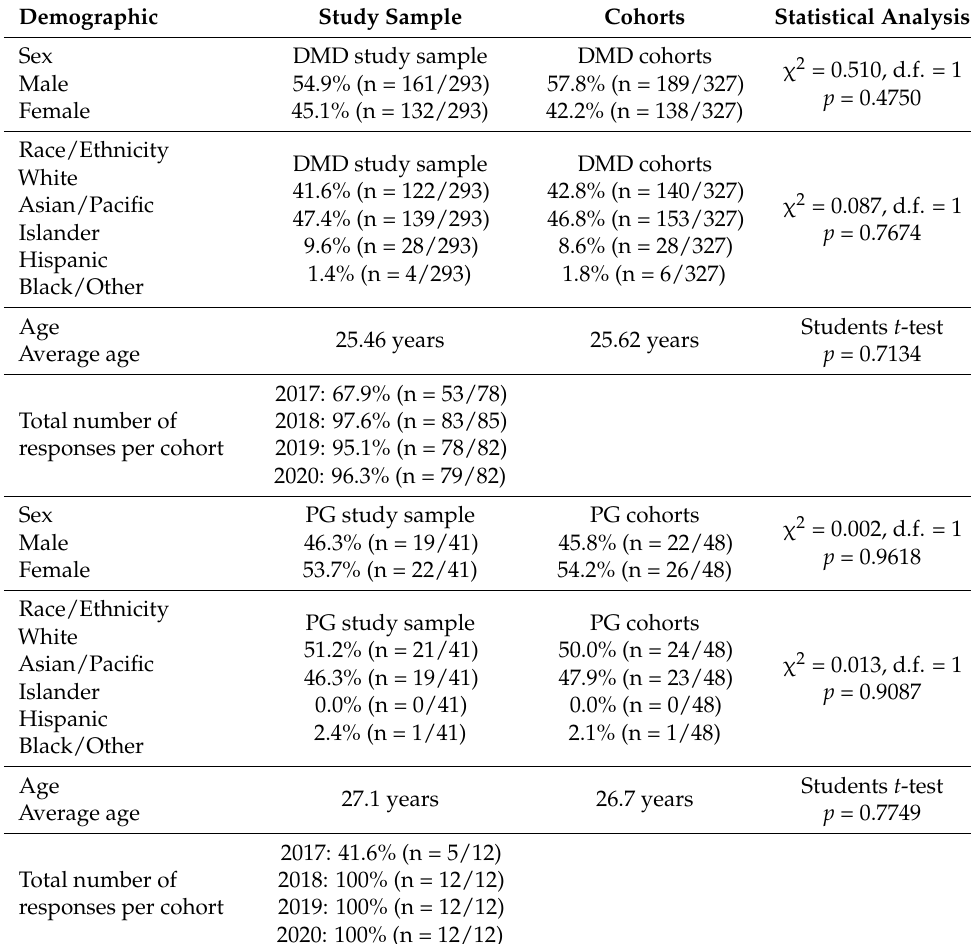
Table 1. Demographic analysis of DMD/PGR cohorts and survey